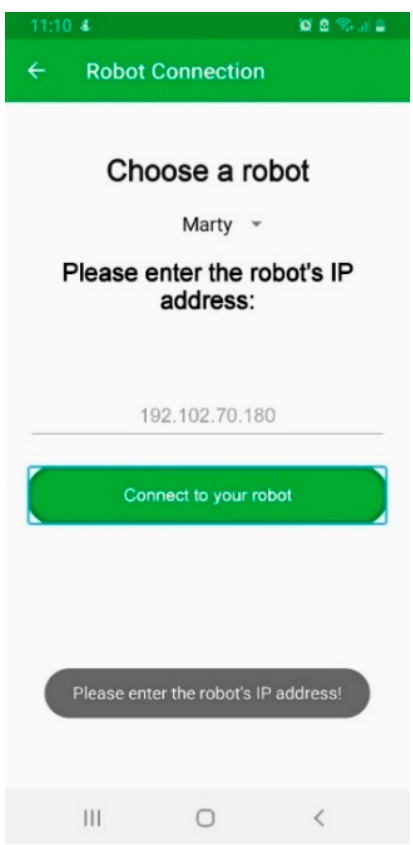
Figure 12. Error null IP address.